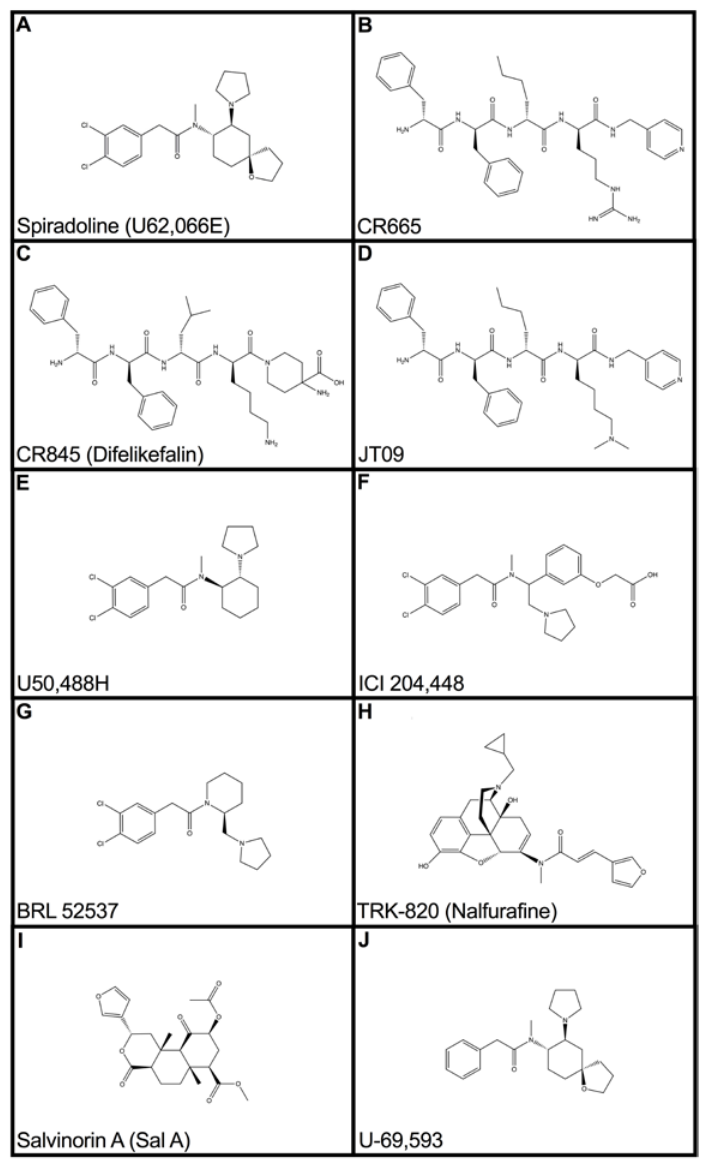
Figure 1. Structures of well-described kappa-opioid receptor agonists and related compounds. The compounds CR665 ( B ), CR845 ( C ), JT09 ( D ), and ICI 204,448 ( F ) are peripherally-selective kappa-opioid agonists (KOAs). Spiradoline ( A ), U50,488H ( E ), BRL 52537 ( G ), TRK-820 ( H ), Salvinorin A ( I ), and U-69,593 ( J ) are centrally-active KOAs.